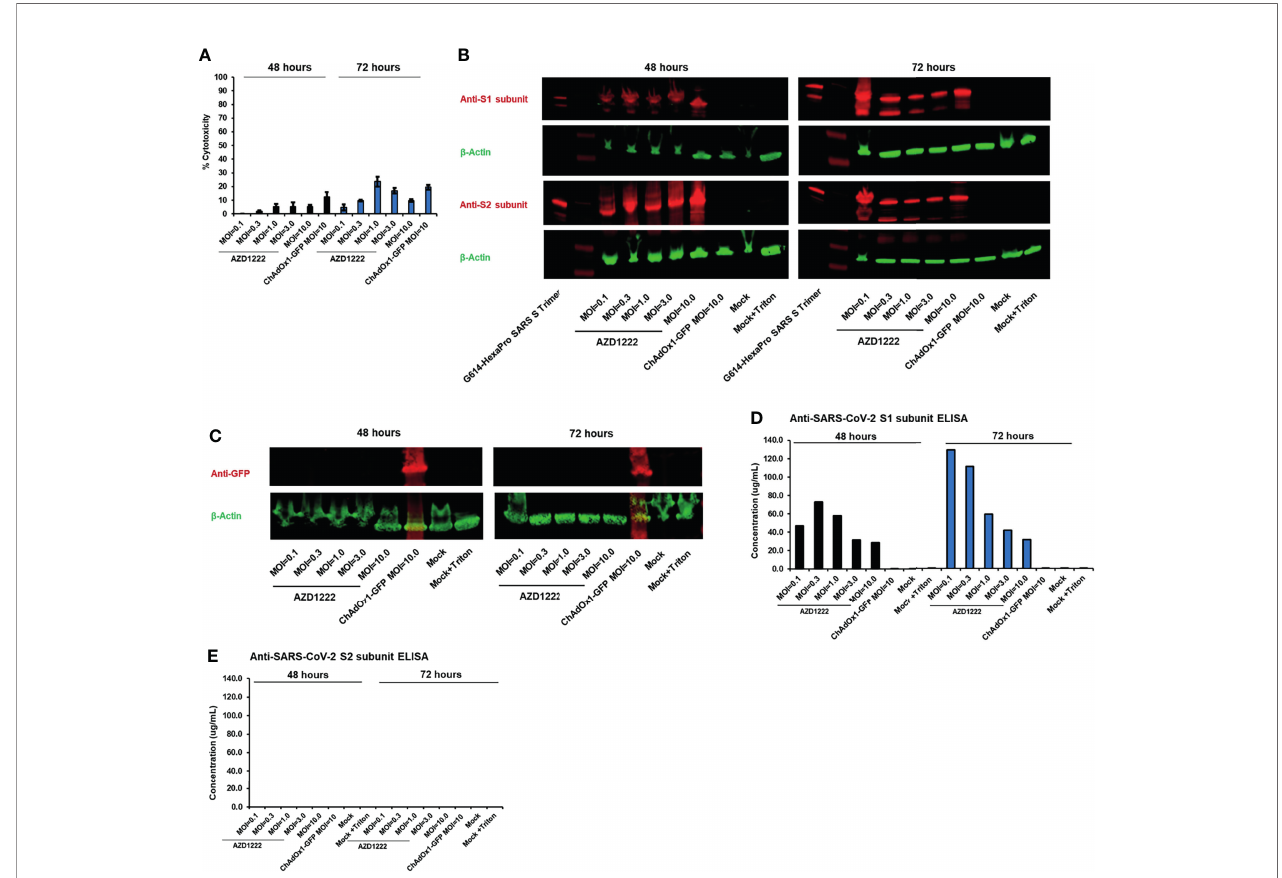
FIGURE 1 | The S1 subunit of the SARS-CoV-2 spike glycoprotein is cleaved in vitro following AZD1222 transduction. (A) Viability of HEK293x cell lines 48 and 72 hours following transduction with AZD1222 at increasing input MOIs or ChAdOx1-GFP control. Error bars show the associated standard deviation for each sample. (B) Expression of SARS-CoV-2 S1 and S2 spike protein subunits 48 or 72 hours post transduction with AZD1222. (C) Expression of GFP control 48 or 72 hours post transduction with ChAdOx1-GFP. (D) Levels of SARS-CoV-2 S1 subunit and (E) full-length spike protein in cell culture supernatants at 48- and 72-hours